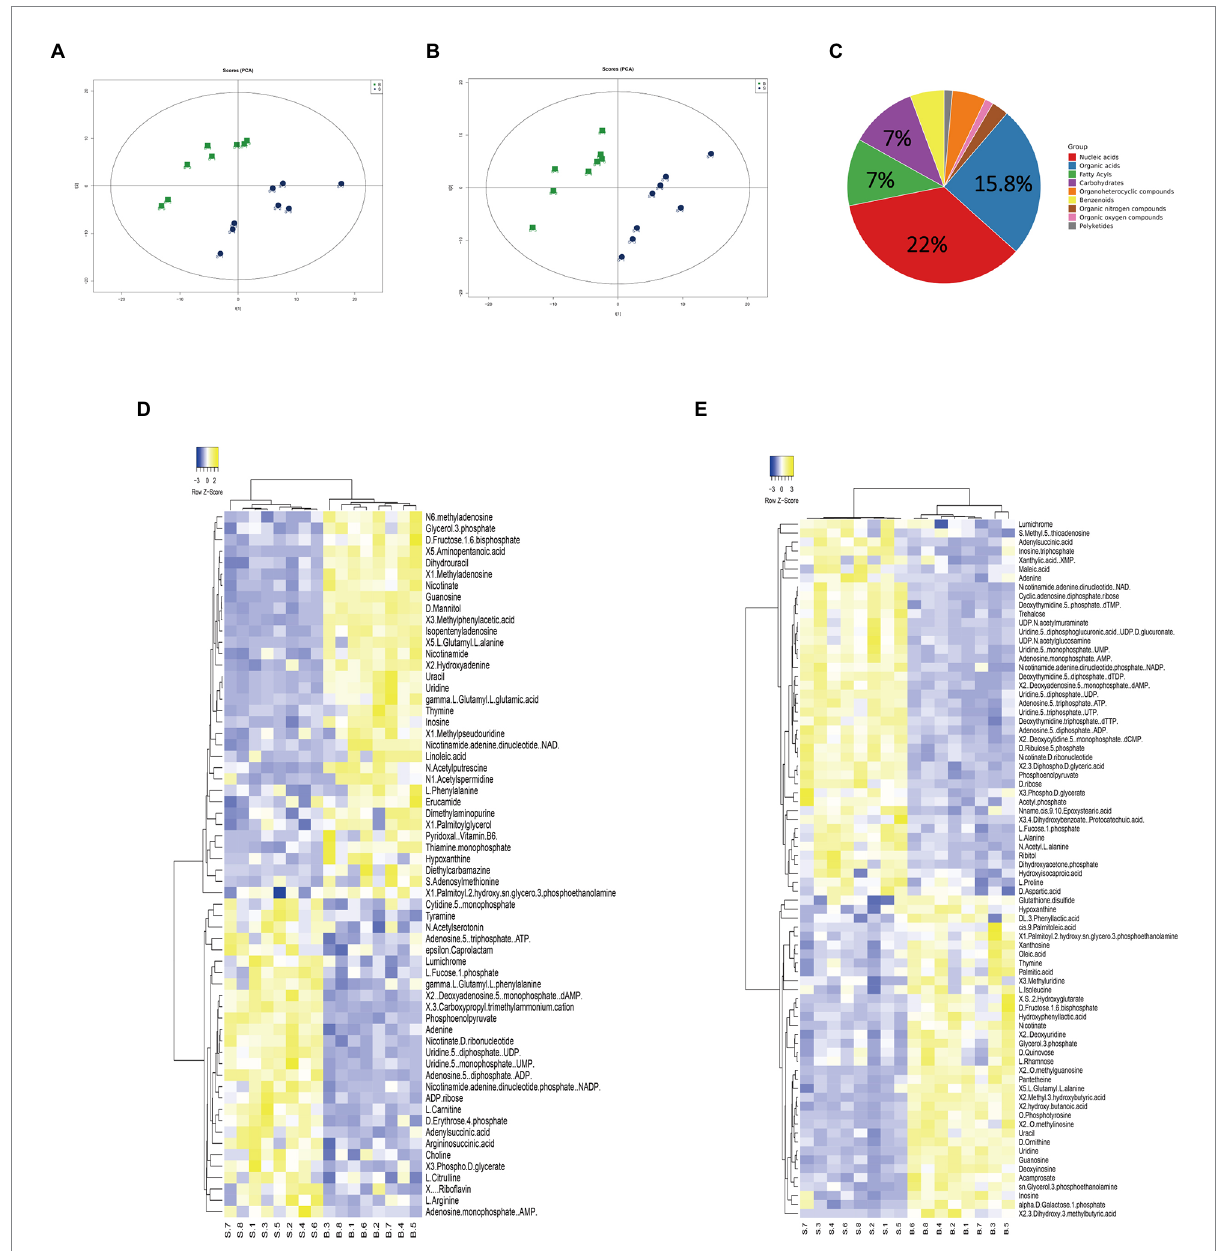
FIGURE 1 Analysis of the SCH-R metabolic profile. (A) PCA score of gentamicin-resistant and sensitive Salmonella in positive ESI modes. (B) PCA score of gentamicin-resistant and sensitive Salmonella in negative ESI modes. (C) Abundance of different categories of metabolites in SCH-R. (D) Cluster analysis of different metabolites in positive ESI modes. (E) Cluster analysis of different metabolites in negative ESI modes. “B” represents gentamicin-induced resistant Salmonella ATCC13312, “S” represents gentamicin-sensitive Salmonella